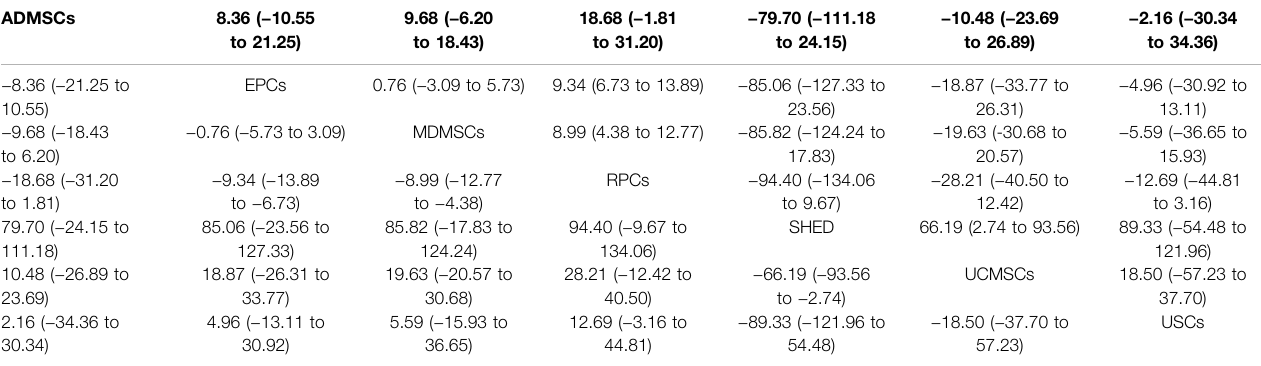
TABLE 10 | Network Meta-analysis results of blood urea nitrogen levels in stem cell groups at 7 days after administration.